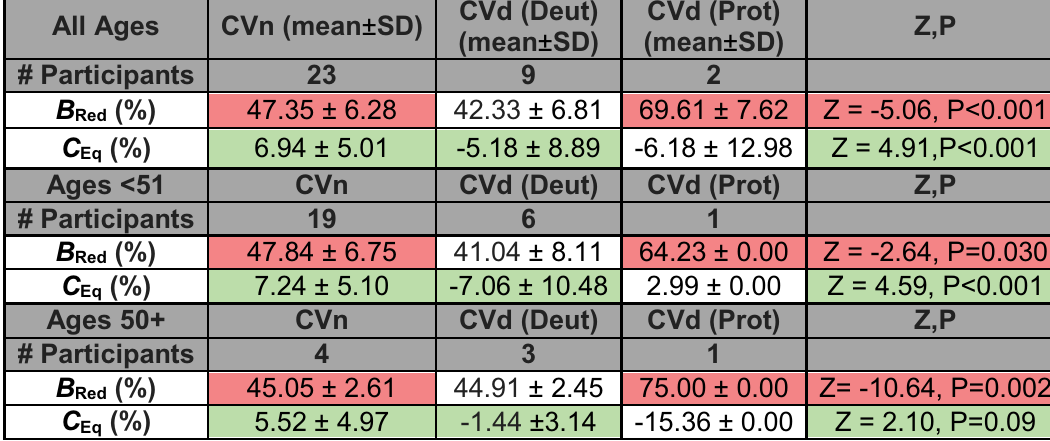
Table 1. Comparison between mean B Red and C Eq values for colour vision groups (top 4 rows) for participants of all ages, (middle 4 rows) for participants of age 30 and under and (bottom 4 rows) for participants over 30 years of age. Red cells highlight the comparison in B Red between normal trichromats and protanopes. Whereas the green cells highlight the comparison in C Eq between normal trichromats and deuteranopes. Note that for all age filters, the differences in B Red for CVn and CVd (Prot) are significant and for all age filters (except for 50 years and over) the differences in C Eq for CVn and CVd are